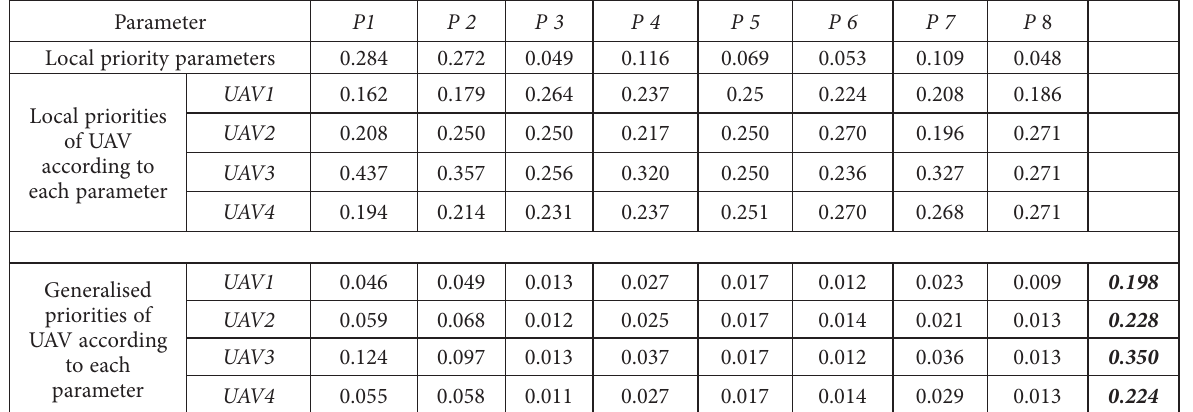
according to each